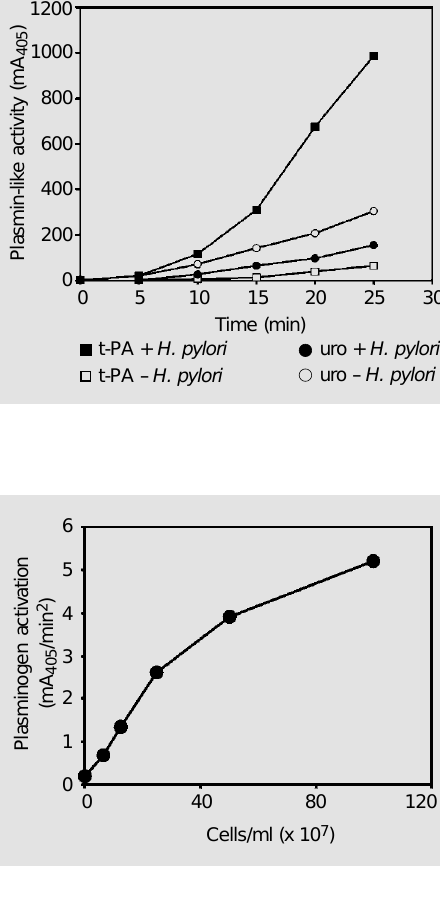
Figure 5 - t-PA and urokinase binding to the surface of H. py- lori . Different amounts of t-PA (A) and urokinase (B) were al- lowed to interact with 10 8